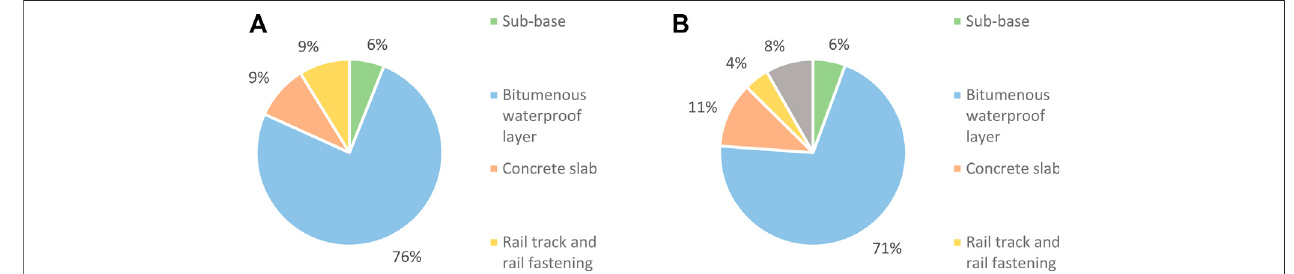
FIGURE 14 | Costs for off-street (A) and on-street (B) components in the construction phase.